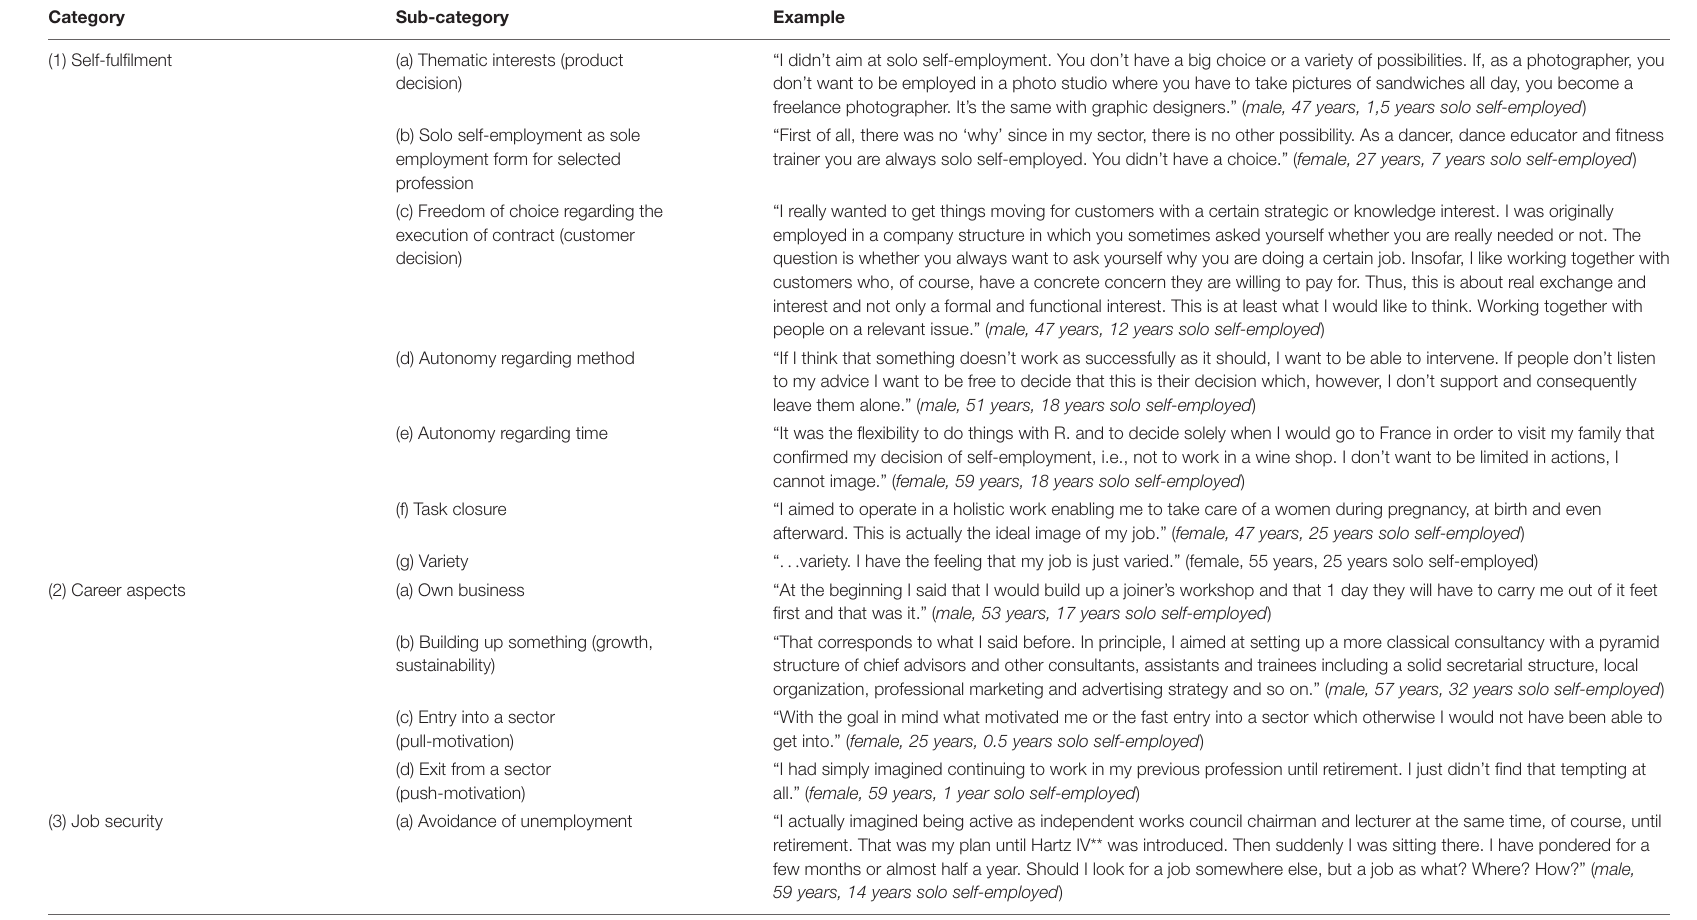
TABLE 5 | Motives for choice of solo self-employment.